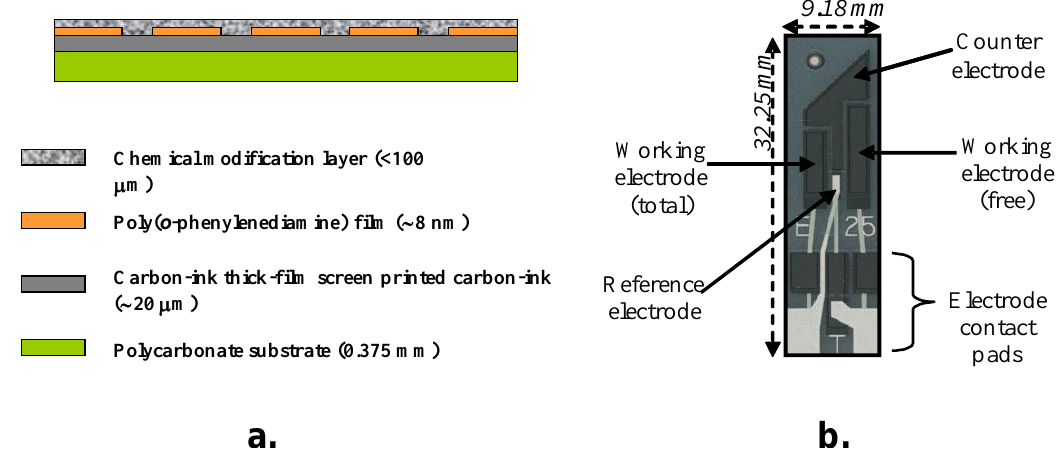
Figure 8. (a) Schematic of final sensor construction; (b) final four-electrode assembly.